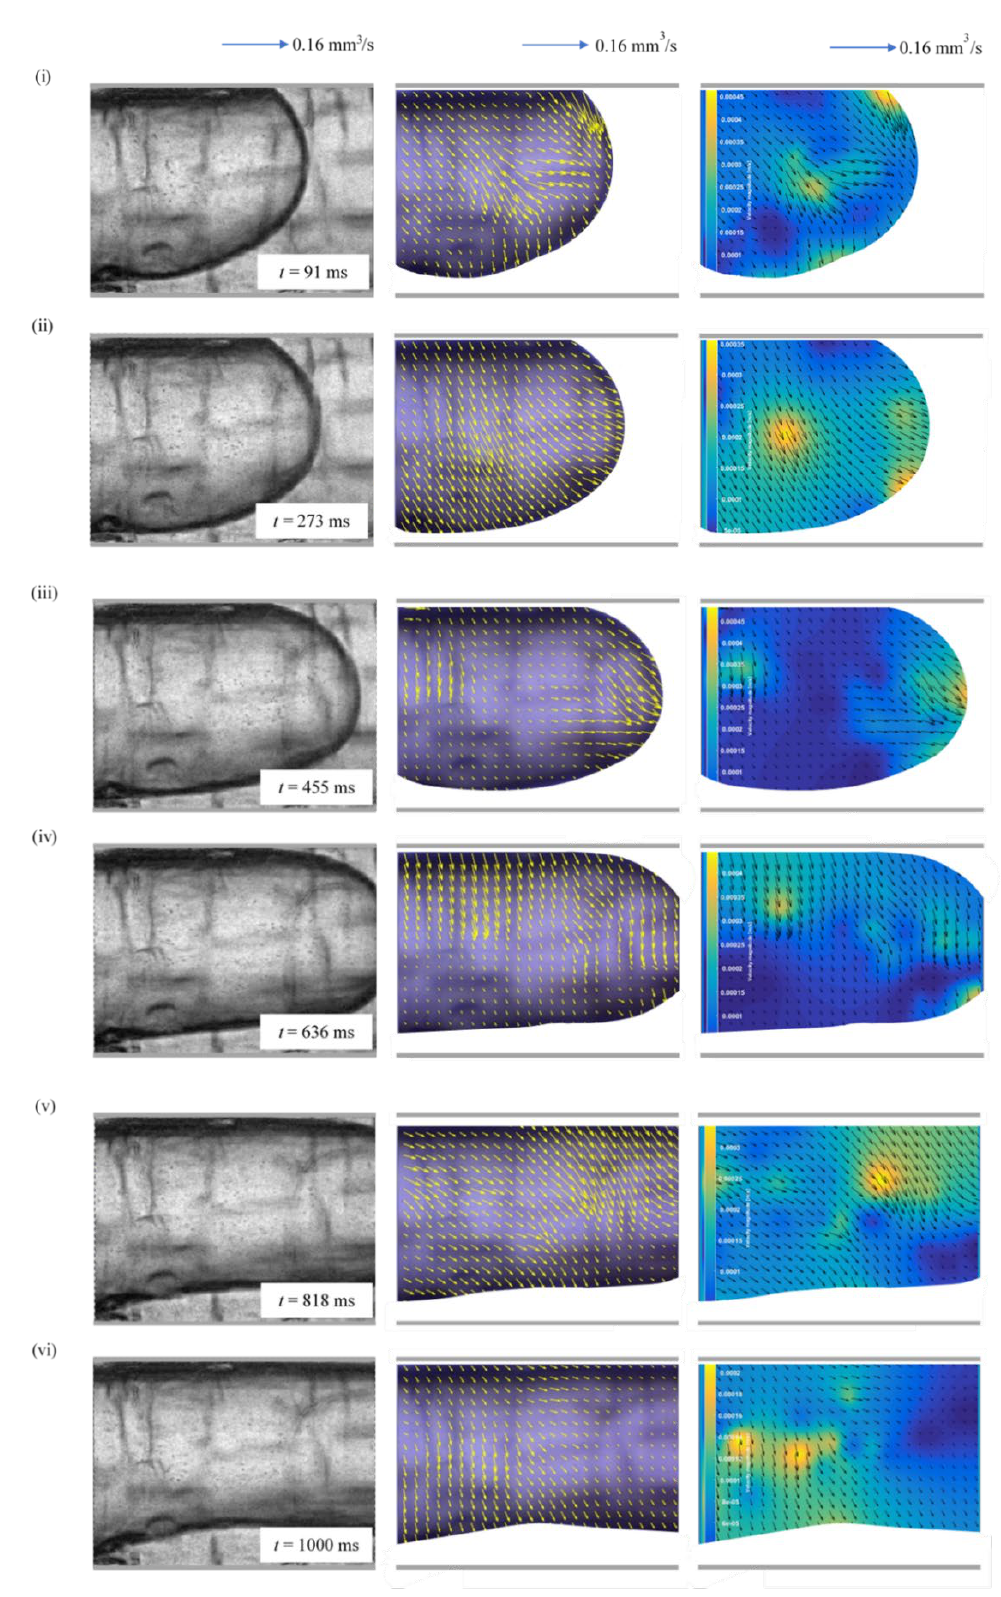
Figure 5. Pre-processing image, vector and velocity magnitude for the offset T-junction microchannel with a radius of 400 µm at ( i ) 91 ms, ( ii ) 273 ms, ( iii ) 455 ms, ( iv ) 636 ms, ( v ) 818 ms and ( vi ) 1000 ms.